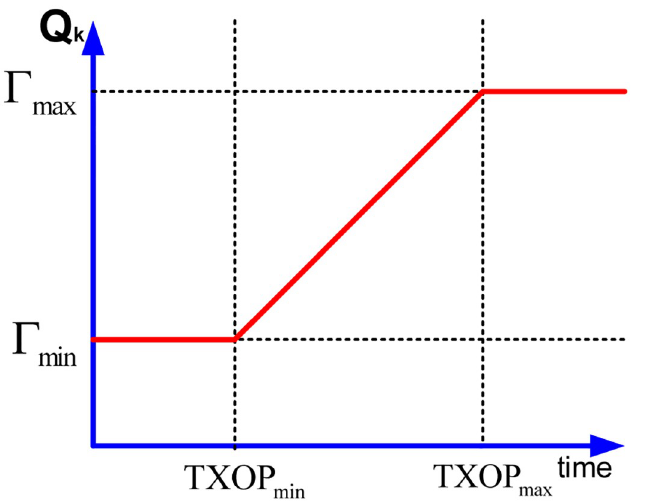
Fig 3. The EDTXOP limit allocation